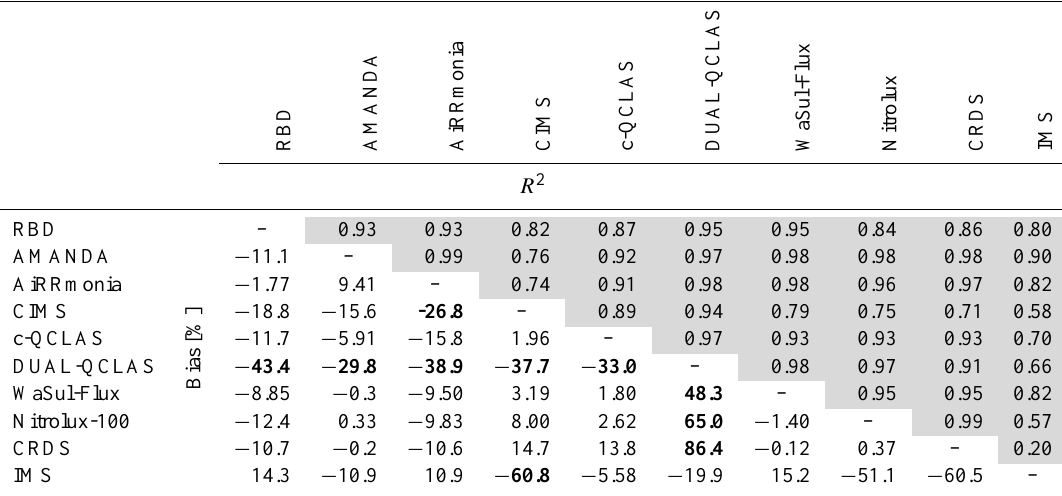
Table 5. Inter-comparison of correlation coefficients and biases between each instrument for the entire data range. Biases are given in the bottom half and correlation coefficients are indicated by the top (grey) of the matrix. Bold numbers indicate high biases ( > 20%), mainly of the